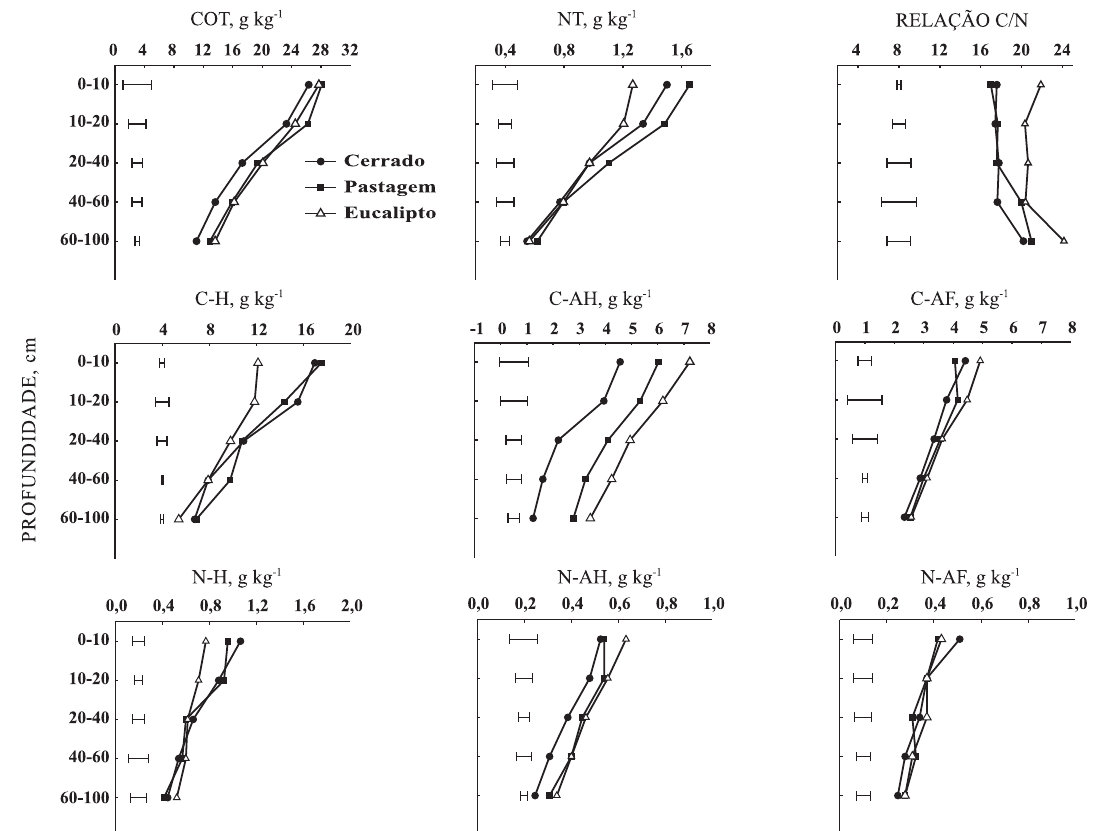
Figura 2. Teores de carbono orgânico total (COT) e nitrogênio total (NT) do solo e das frações humina (H), ácidos húmicos (AH) e ácidos fúlvicos (AF) nas diferentes coberturas vegetais (Cerrado, pastagem e eucalipto). As barras horizontais indicam a DMS (5 %), entre as médias, de acordo com a camada de